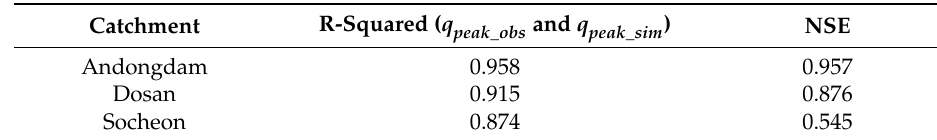
Figure 9. Comparison of the observed peak flow (qpeak_obs) and the simulated peak flow (qpeak_sim) based on the rational method and simulated C ( C sim ). Table 4. R-squared and NSE values for the observed peak flow ( q peak _ obs ) and simulated peak flow ( q peak _ sim